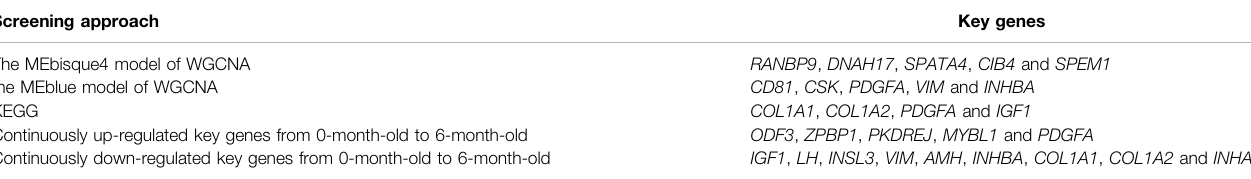
TABLE 1 | List of Obtained key genes from different approaches. Screening approach Key genes